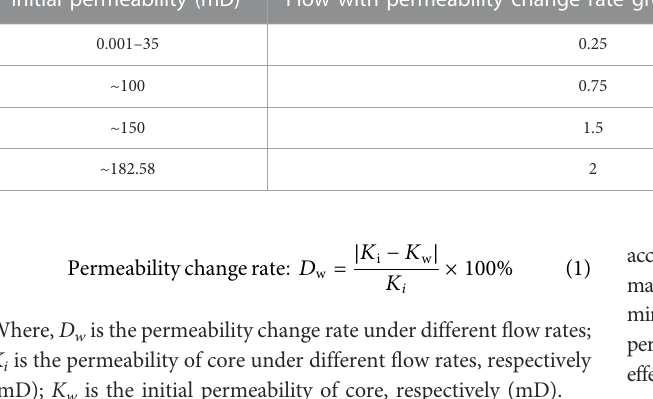
TABLE 2 Results of velocity sensitivity damage test. Initial permeability